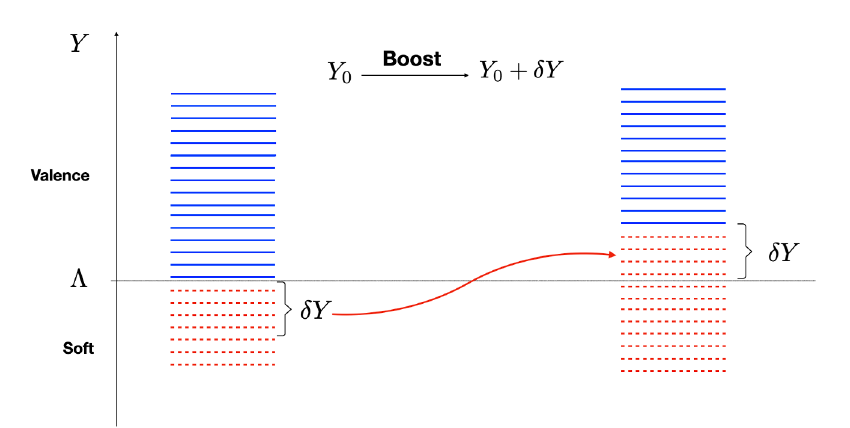
Figure 1. The longitudinal momenta of the fast moving hadrons (projectiles) are divided into valence modes and soft modes with a separation scale Λ . After a di ff erential boost of δ Y , the soft modes within the range δ Y right below the cuto ff Λ will emerge above Λ .